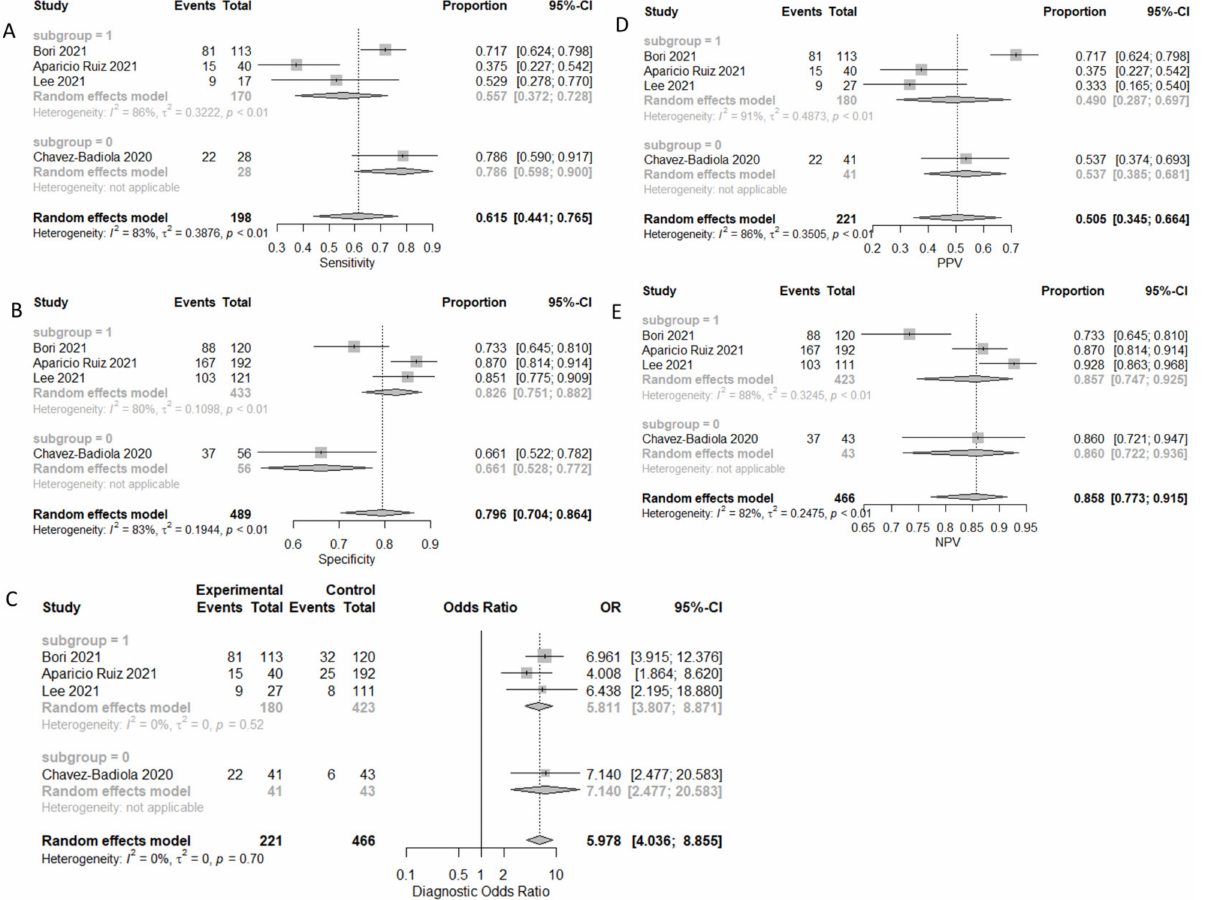
Figure 8. Forest plots representing: ( A ) sensitivity; ( B ) specificity; ( C ) DOR; ( D ) PPV; ( E ) NPV of the ploidy prediction outcome. Subgroup “0” represents static images as type of input, and subgroup “1” represents